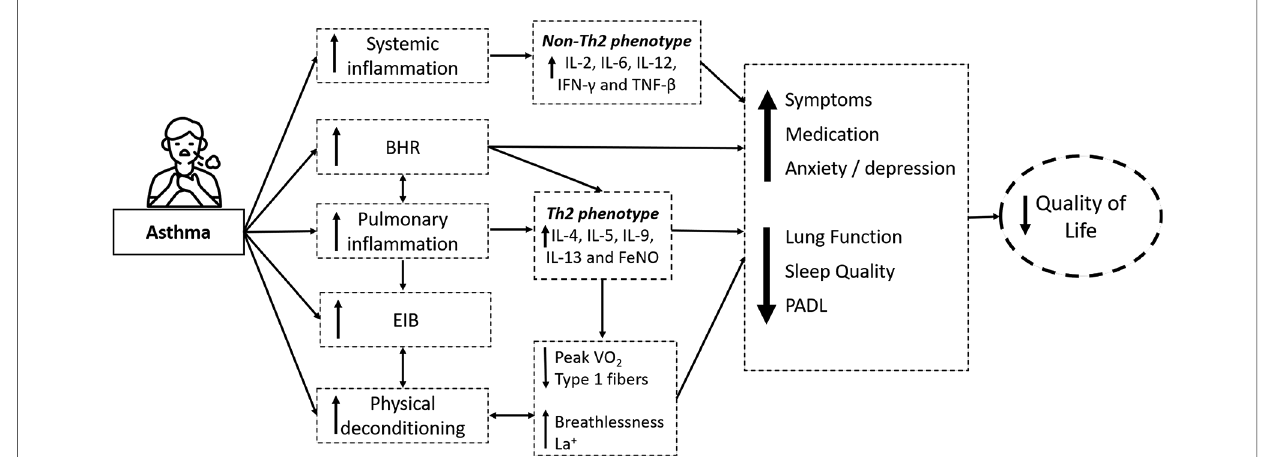
FIGURE 1 Illustrative fi gure presenting clinical outcomes, in fl ammatory mechanisms, and comorbidities in individuals with asthma. BHR: Bronchial hyperresponsiveness; EIB: exercise-induced bronchoconstriction; IL: interleukins; IFN-y: Interferon-gamma; TNF- β : Tumor Necrosis Factor, FeNO: Fractional Exhaled Nitric Oxide; PeakVO 2 : Peak oxygen consumption; La + : Blood lactate during moderate exercise; PADL: Physical Activity in Daily Life; Icon made by AomAm from www. fl aticon.com.